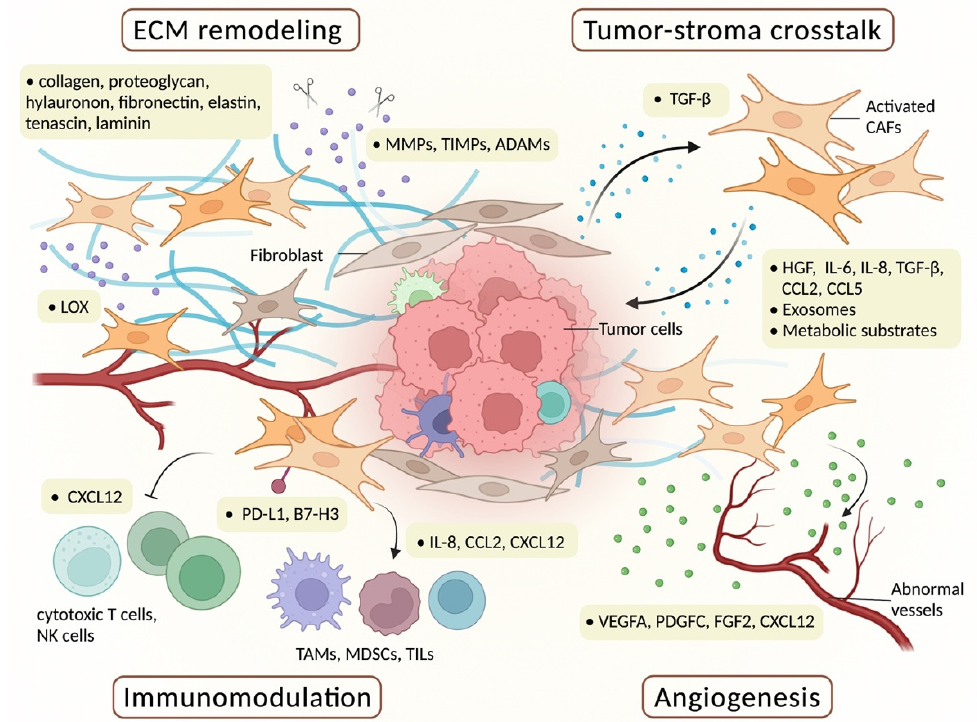
Figure 2. The multifaceted functions of CAFs (cancer-associated fibroblasts) in the TME (tumor microenvironment). Cancer cells can activate tumor-surrounding fibroblasts and other cells by TGF- β and other signaling pathways to become CAFs, which modulate the TME and promote cancer progression by four aspects: (1) CAFs controlling the abnormal and pro-metastasis ECM (extracellular matrix) remodeling by producing and crosslinking ECM components, and the ECM might be degraded by MMPs (matrix metalloproteases) and other enzymes. (2) CAFs interact with cancer parenchyma through multiple kinds of growth factors, cytokines, and chemokines, such as HGF, IL-6, IL-8, CCL2, and CCL5. CAFs also secret metabolic substrates to support tumor metabolism. CAFs also produce exosomes mainly containing miRNA to regulate tumor cells. (3) CAFs promote the abnormal angiogenesis of cancer by producing VEGFA, PDGFC, FGF-2, and CXCL12. (4) CAFs exert a modulatory role of the tumor-infiltrating immune cells, such as TAMs, MDSCs, TILs, cytotoxic T cells, and NK cells.